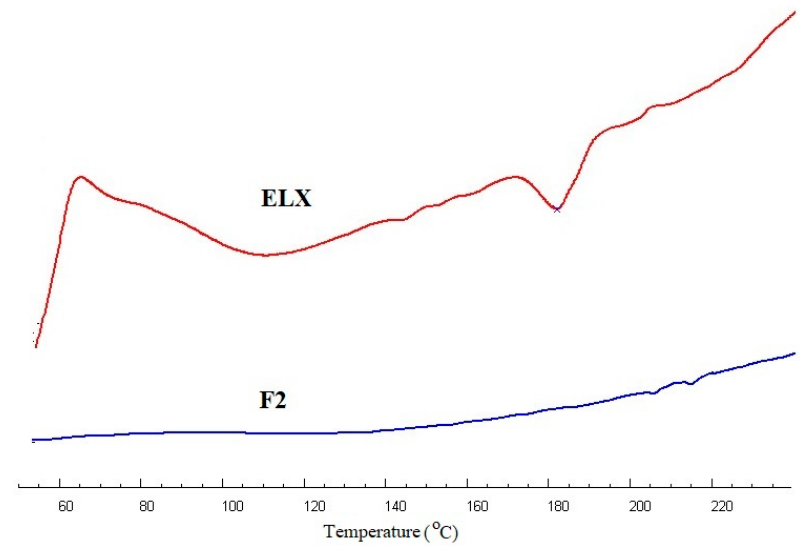
Figure 2. DSC spectra of pure ELX and ELX loaded SLNs (F2).